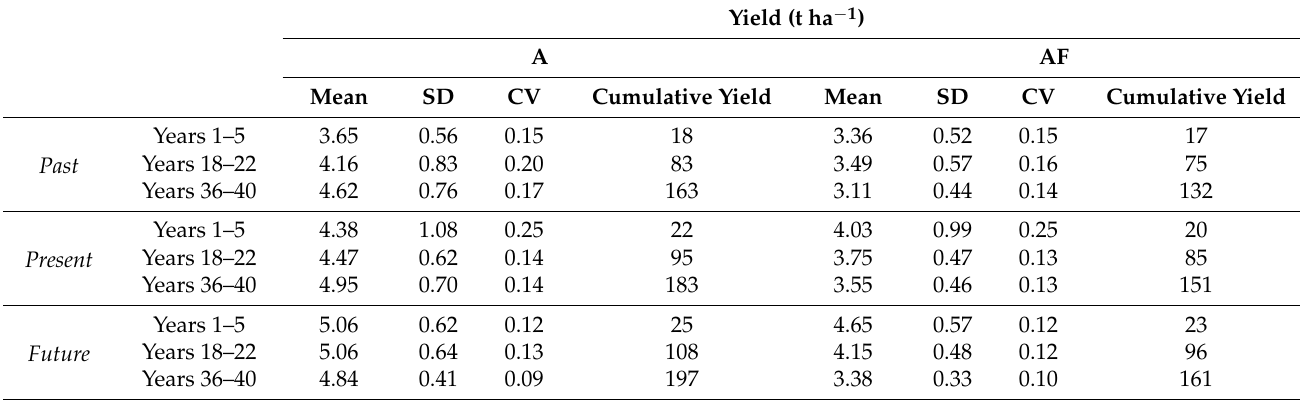
Table 3. Yields by agricultural system, climatic scenarios, and typical parts of the 40-year rotation (start, middle, end). Cumulative yield is reported for years 5, 22, and